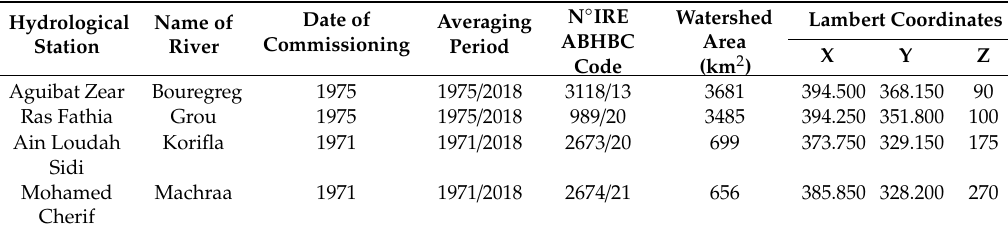
Table 2. Characteristics of the four hydrological stations